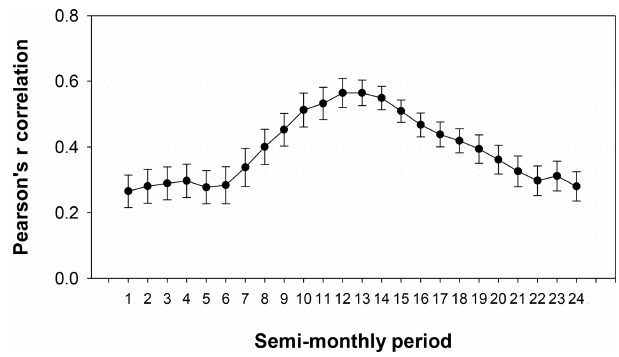
Figure 3. Spatial average and standard error of the Pearson’s r cor- relation coefficient between the sNDVI and SPEI time